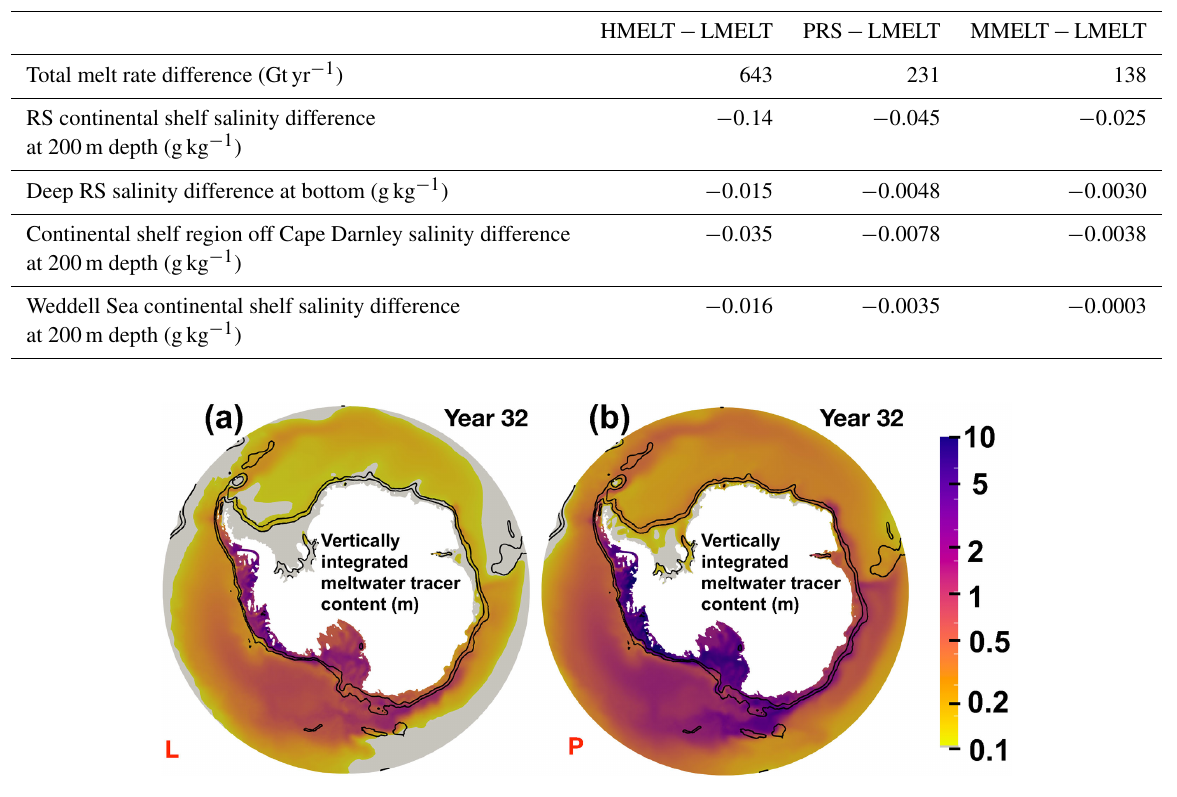
Figure 5. January mean vertically integrated tracer contents representing the glacial meltwater only from ice shelves in the AS and BS for (a) LMELT and (b) PRS cases for year 32. The letters P and L at the bottom left of each panel indicate PRS and LMELT, respectively. The bathymetry contours of 1000 and 2500m are shown with black lines. Values lower than 0.1 are indicated in